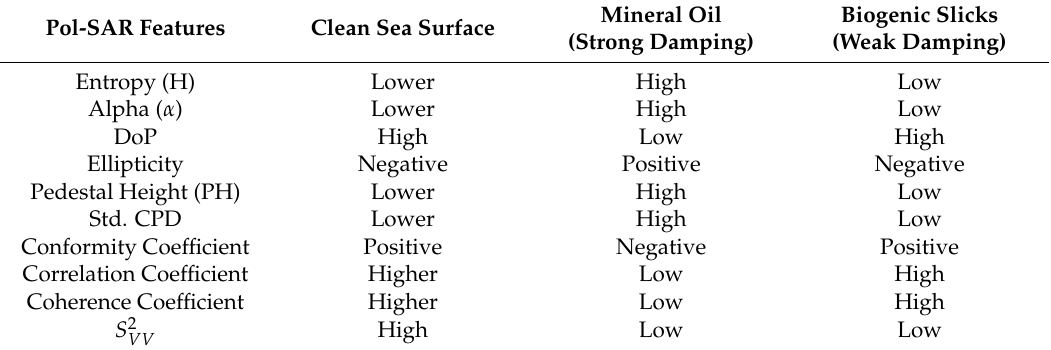
Table 1. Behaviors of main polarimetric SAR features on different types of surfaces. DoP, degree of polarization; CPD, co-polarized phase